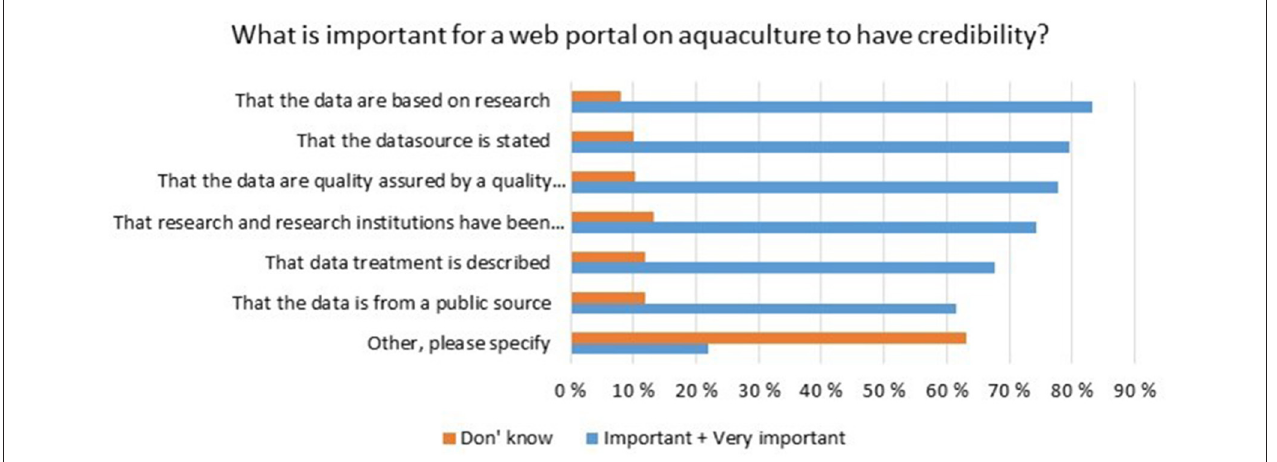
FIGURE 3 | Survey results: Share of respondents that find issues “Important” or “Very important” for a web portal on aquaculture to be